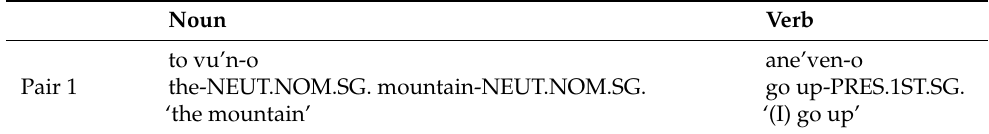
Table 2. Example material for the pantomime intervention.